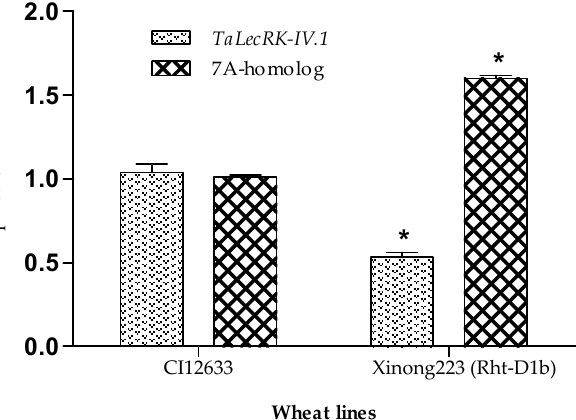
Figure 4. RT-qPCR analysis of the expression of TaLecRK-IV.1 and its 7A-homolog gene in wheat cv. CI12633 and in wheat lineXinong223 ( Rht-D1b ). For comparison, the expression of TaLecRK-IV.1 and its paralogue in CI12633 was employed as control. The relative gene expression (comparative 2 − ∆∆ C ) method was employed. The endogenous reference gene TaActin was used to normalize the expression levels of TaLecRK-IV.1 and its 7A-homolog. Asterisks indicate significant expression difference at 0.05 probability level as compared to the relative expression in control by using the Student’s t -test.